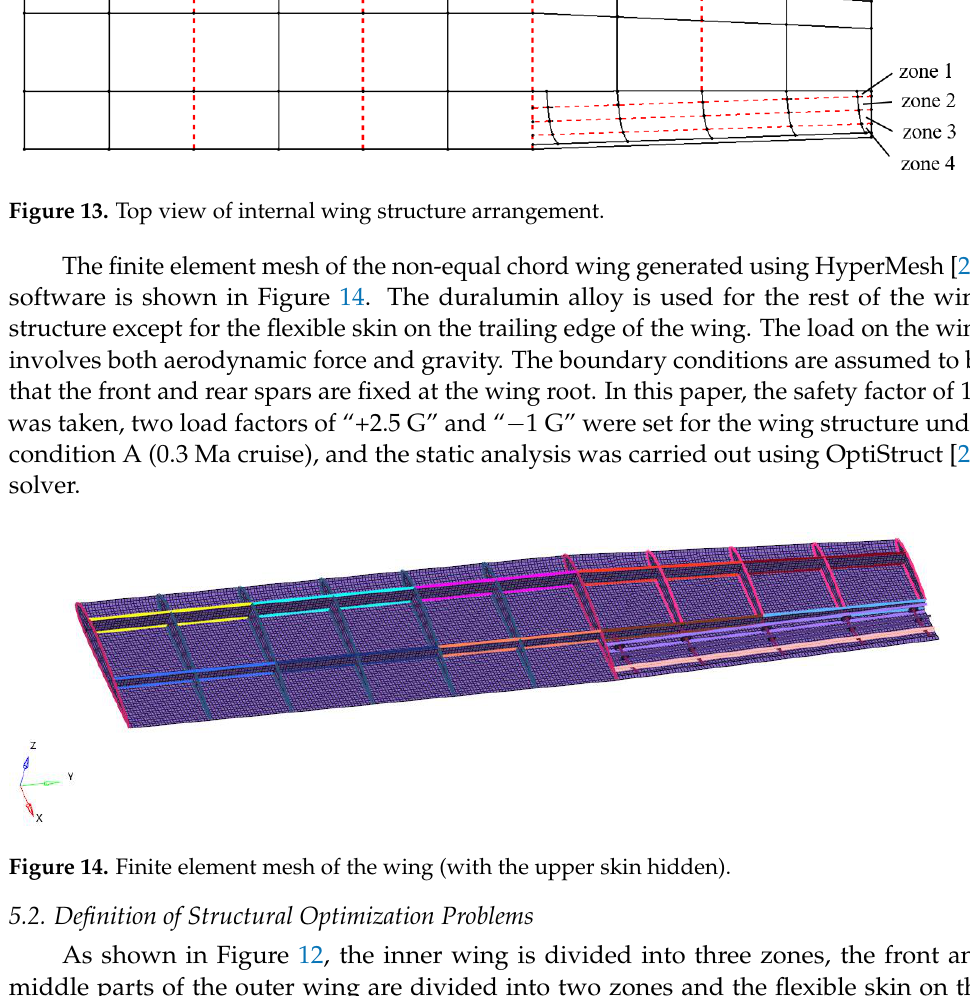
Figure 12. Curved beam – planar disk.